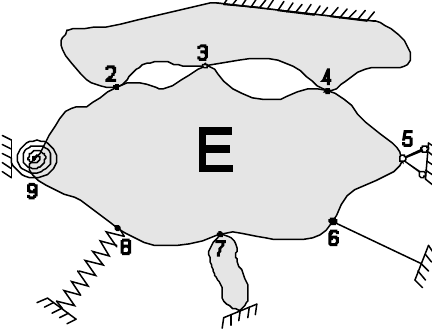
Fig. 1. Element E with interface nodes on